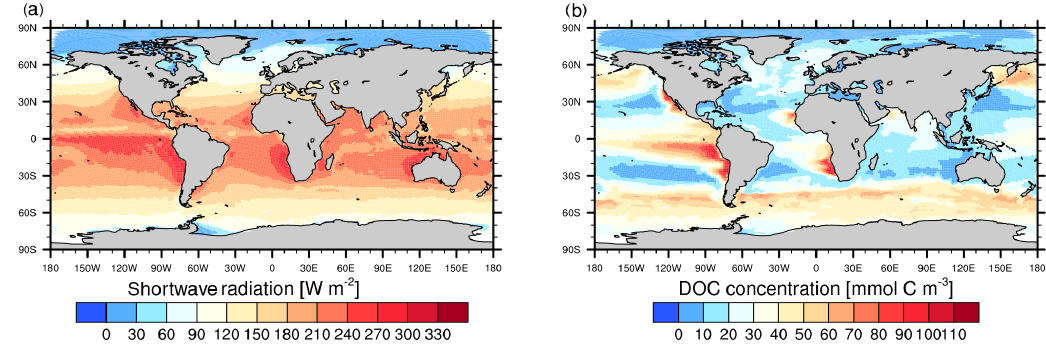
Figure 6. Annual mean shortwave radiation (Wm − 2 ) (a) and semi-labile DOC concentration (mmCm − 3 ) (b)